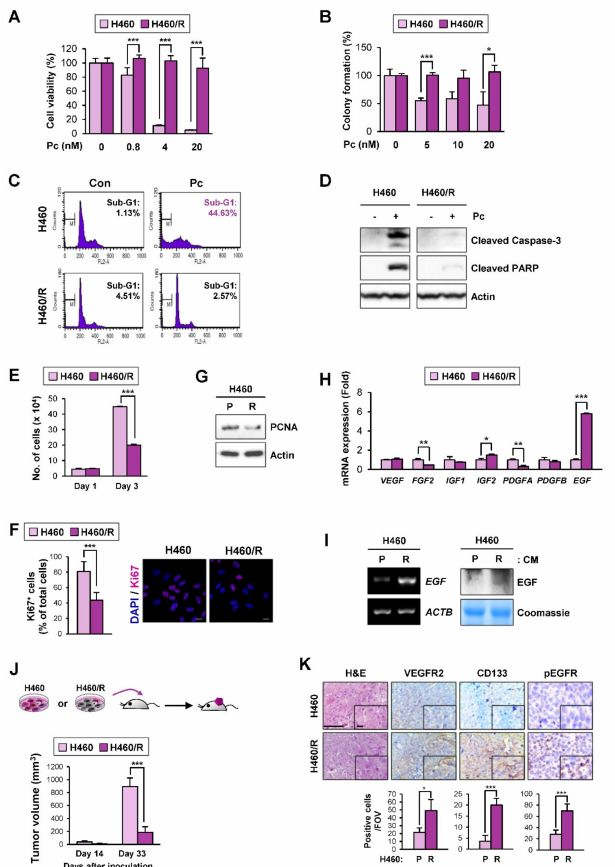
Figure 4. Increased EGF expression in the quiescent-like chemoresistant cell population. ( A–D ) Acquisition of resistance to paclitaxel in H460 / R cells compared with the corresponding parental cells (H460) was determined by a crystal violet assay ( A ), a soft agar colony formation assay ( B ), a flow cytometric analysis of PI-stained cells ( C ), and a Western blot analysis determining the cleavage of poly (ADP-ribose) polymerase (PARP) and caspase-3 ( D ). ( E–G ) Reduced cell proliferation in H460 / R cells compared with H460 cells was determined by a cell counting assay ( E ), an analysis of Ki67-positive cells using immunofluorescence staining (scale bar: 20 µ m) ( F ), and a Western blot analysis to determine the protein expression of proliferating cell nuclear antigen (PCNA) ( G ). ( H ) The mRNA expression of several proangiogenic soluble factors in H460 / R cells compared with H460 cells was determined by a real-time PCR. ( I ) Left: EGF mRNA expression in H460 and H460 / R cells was determined by RT-PCR. Right: EGF protein levels in conditioned medium (CM) derived from H460 and H460 / R cells were determined by Western blot analysis. ( J ) Changes in tumor volumes in xenograft tumors derived from H460 ( n = 4) and H460 / R ( n = 4) cells at days 14 and 33 after cell inoculation. ( K ) IHC analyses to assess the accumulation of vascular endothelial cells (VEGFR2 + ) and EPCs (CD133 + ) and the activation of EGFR [pEGFR (Y1068) + ] in H460 / R tumor xenografts. Scale bar: 50 µ m. Scale bar (inset): 10 µ m. Bottom: quantification of cells positive for each marker per field of view (FOV, n = 12 from at least three tumors) is depicted as a graph. For all panels, the bars represent the mean ± SD. * p < 0.05, ** p < 0.01, and *** p < 0.001, as determined by two-tailed Student’s t